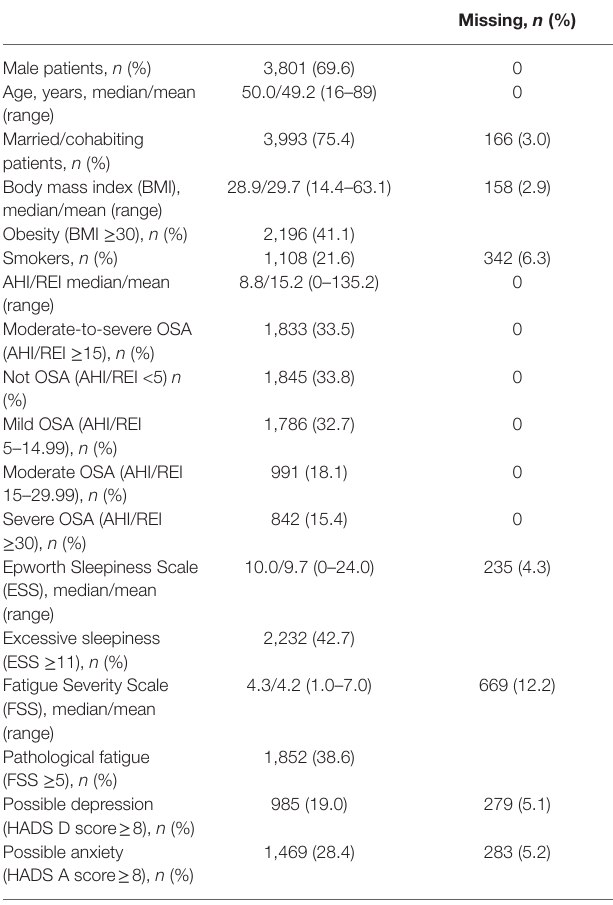
TABLE 1 | Background characteristics of patients referred with suspected obstructive sleep apnea (OSA) to the centre for sleep disorders at Haukeland University Hospital in Bergen, Norway ( n =